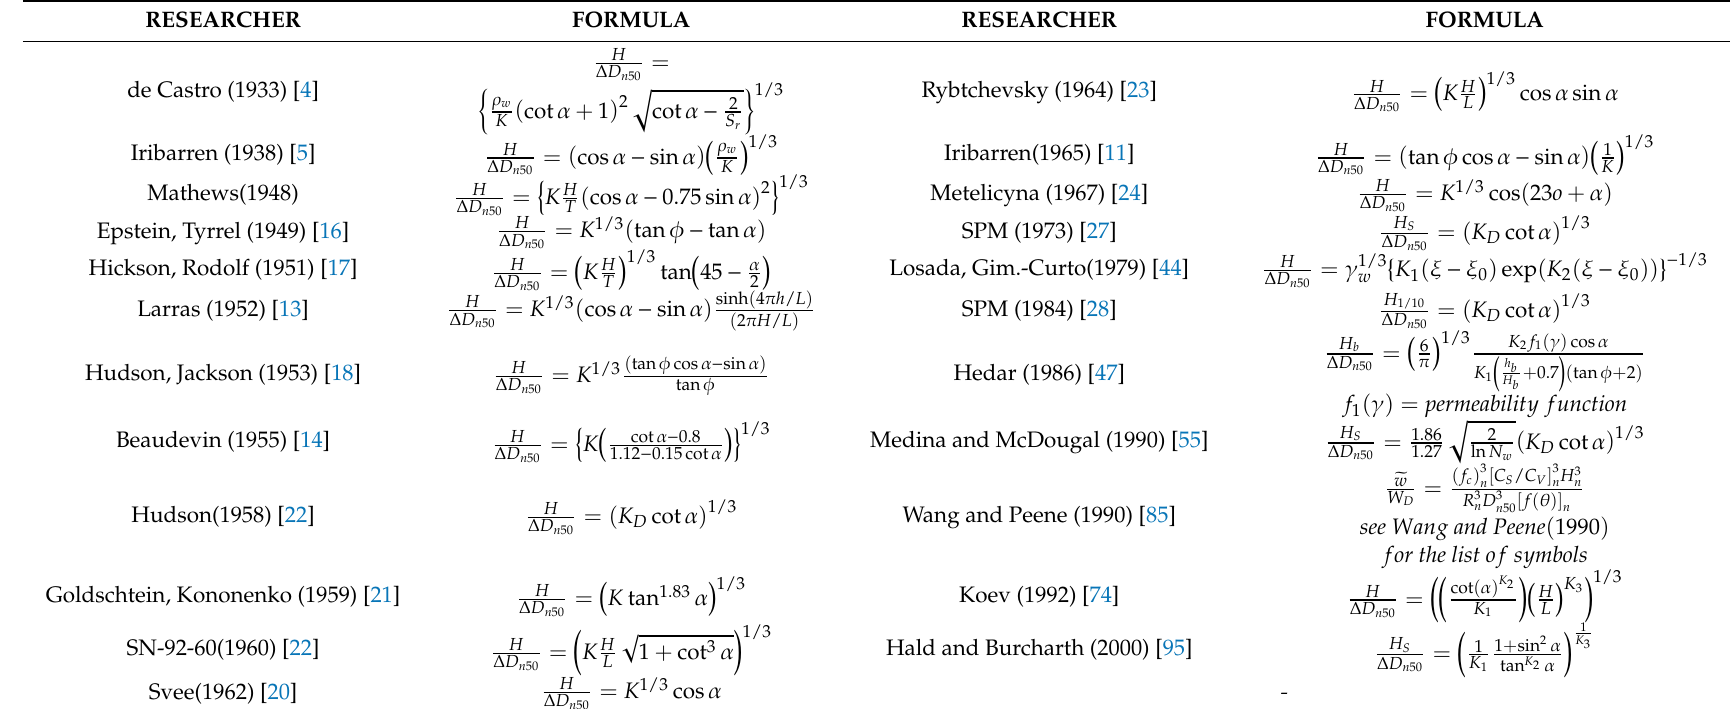
Table 1. Review of hydraulic stability formulae (extended from Hald [8]). See Appendix B for the list of